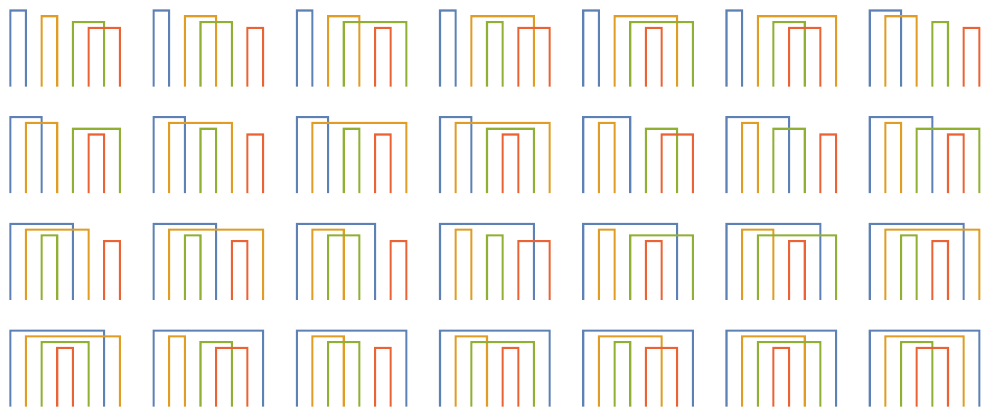
Figure 9 . The diagrams with one intersection contributing to the 8th moment.